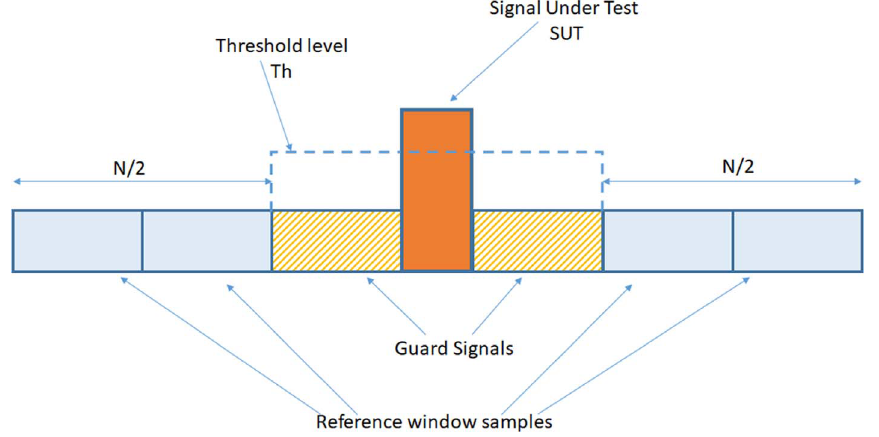
Fig. 13. Principle of CFAR